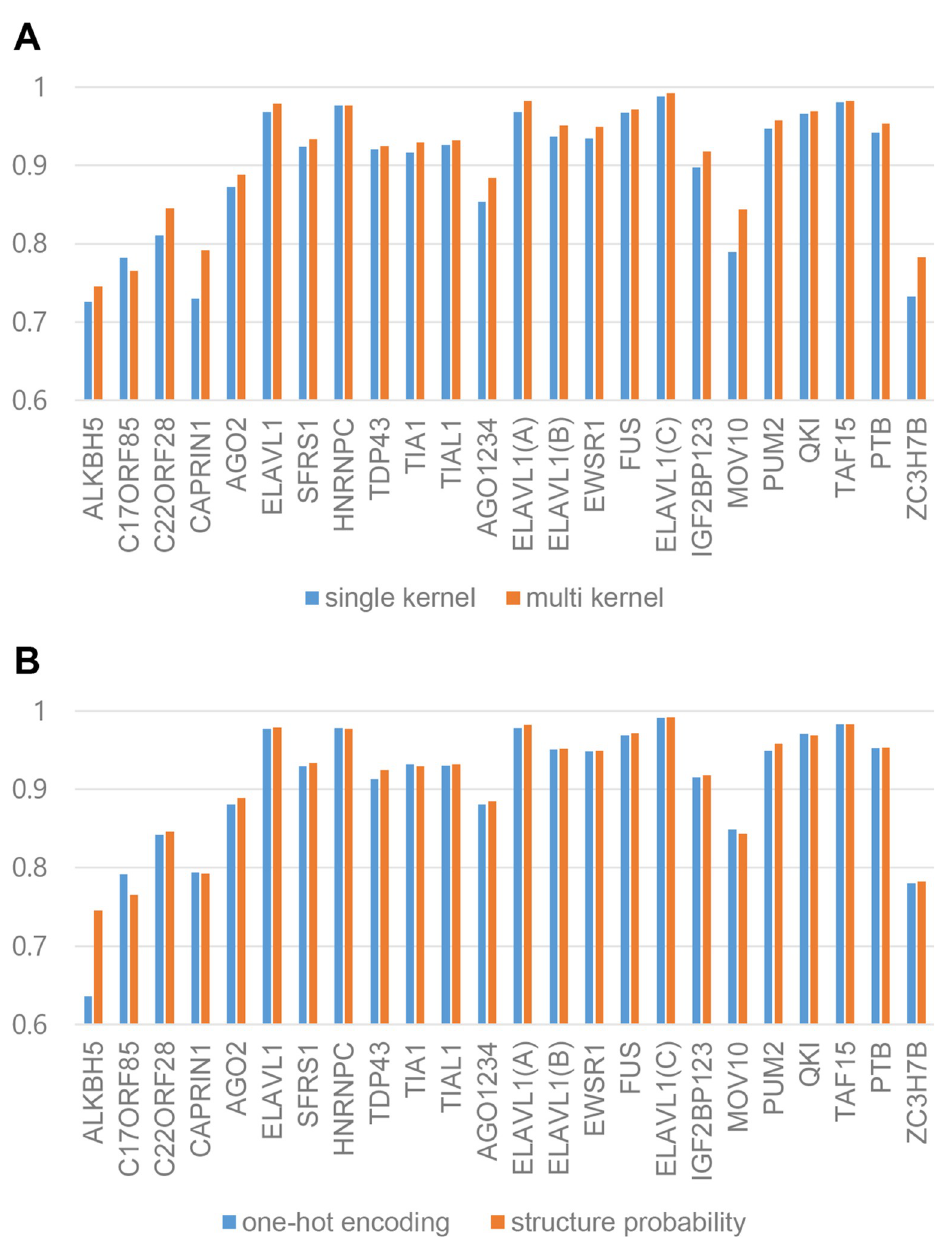
Fig 3. Contributions of various information in mmCNN by comparing AUC of RBP-24. (A) Comparison between single filter mmCNN and multi-sized filter mmCNN using RBP-24 dataset. (B) Better structure representation selection by comparison between one-hot encoded RNA and structure probability